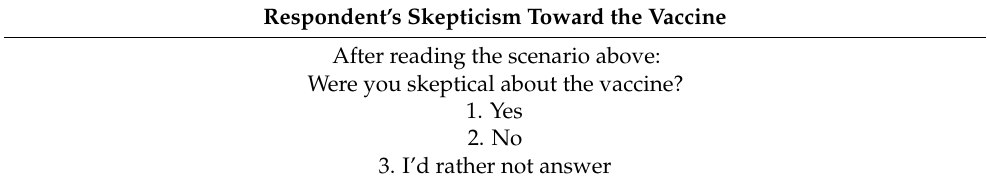
Table A2. Respondent’s Skepticism Toward the